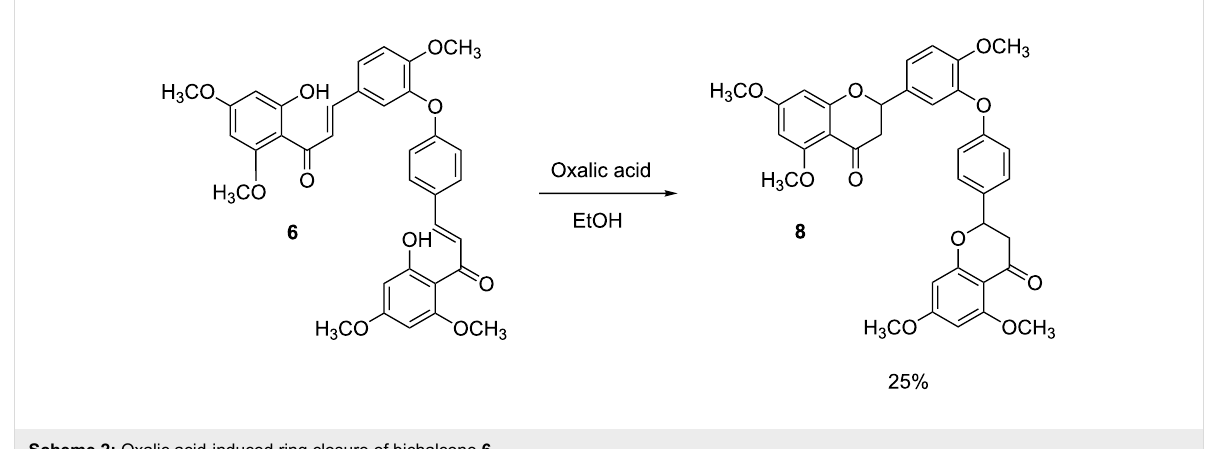
Scheme 2: Oxalic acid-induced ring closure of bichalcone 6